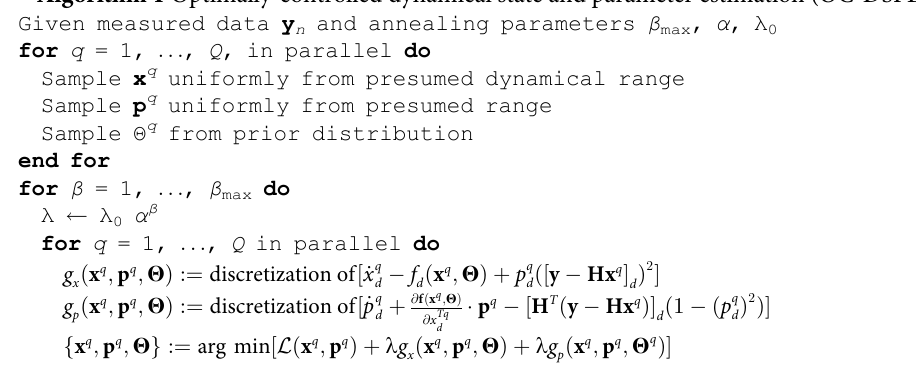
Algorithm 1 Optimally-controlled dynamical state and parameter estimation